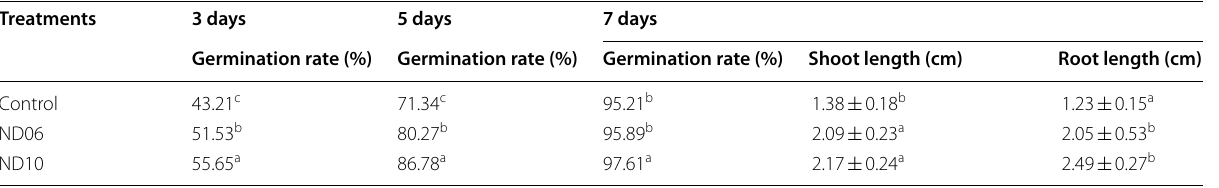
The data represent the mean standard error (SE) ( n 20); Values in the same column with the same letter(s) are not significantly different as determined by the HSD ± = test ( P < 0.05)